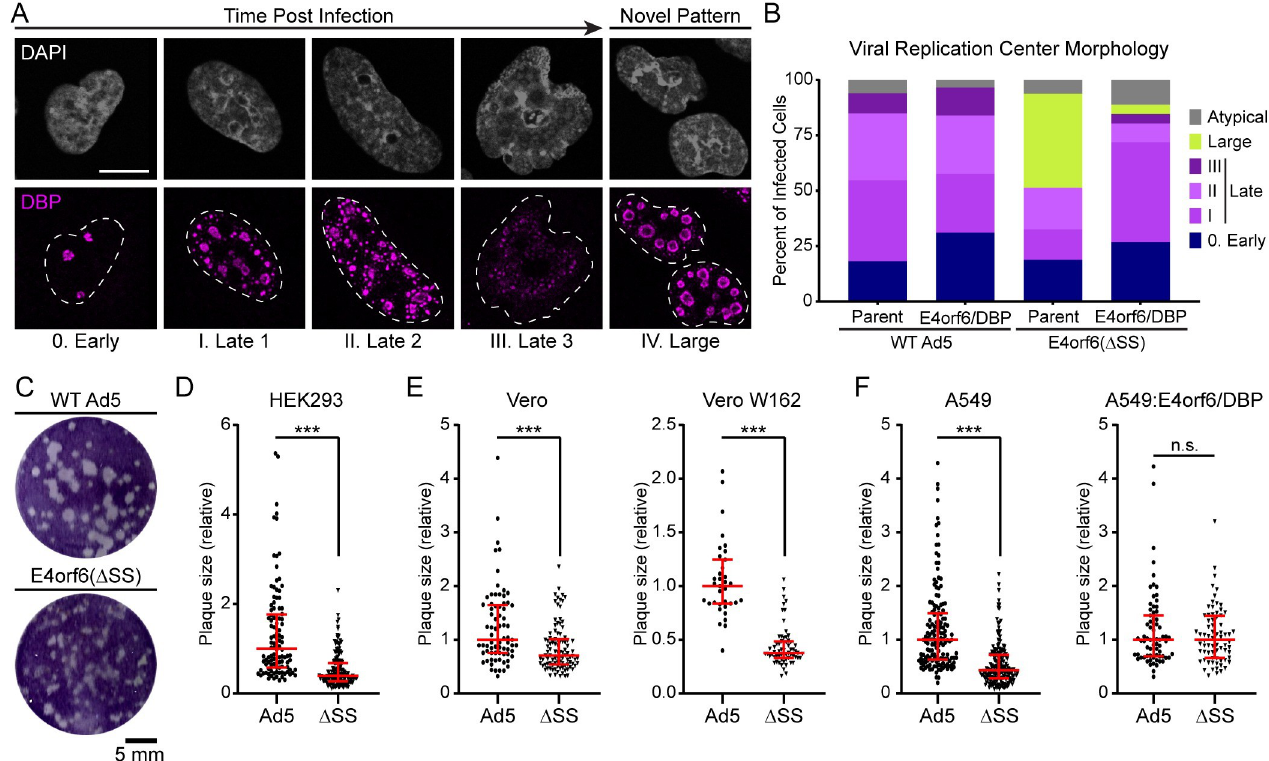
Fig 7. Loss of E4orf6/DBP leads to altered viral replication center morphology and small plaque phenotypes. (A) Wildtype adenovirus infection leads to temporal progression of viral replication center (VRC) morphology progressing from early stage (0. Early) through three distinct stages of late replication centers (Late 1–3). A novel, large replication center morphology was seen with infection of E4orf6 Δ SS virus. Representative immunofluorescence images for each stage are shown by staining A549 cells with VRC marker DBP (magenta) and DAPI for DNA (grey). (B) Parent A549 (Parent) or A549 cells expressing E4p-flag-E4orf6/DBP (E4orf6/DBP) were infected with WT Ad5 or E4orf6 Δ SS virus for 24 hours. Viral replication centers were stained for DBP, and morphology was scored in a blinded manner using the key provided in panel A . The percentage of infected cells demonstrating each replication center morphology is shown as bar chart. Data are representative of three independent experiments. (C) HEK293 cells were infected with limiting dilution of WT Ad5 or E4orf6 Δ SS for six days to allow the formation of plaques. Plaque formation was negative stained with crystal violet and imaged. Scale bar shows 5 mm. (D) WT Ad5 or E4orf6 Δ SS ( Δ SS) plaque size in HEK293 cells was quantified with ImageJ and normalized to the median plaque size in WT infection. Individual plaques are plotted as a single point. (E) Plaque size was quantified in Vero cells or Vero-W162 cells. W162 cells express the adenovirus E4 region in trans and complement the loss of E4orf6/7 in the Δ SS virus. (F) Plaque size was quantified in A549 cells or A549:E4orf6/DBP cells. The A549:E4orf6/DBP cells express E4orf6/DBP under control of the E4 promoter in trans , and thus complement the loss of E4orf6/DBP in the Δ SS virus. For all plaque assays, red error bars denote median and interquartile range. Statistical significance was performed using non-parametric Mann-Whitney t-test (n.s., not significant; ��� , p- value < 0.001).